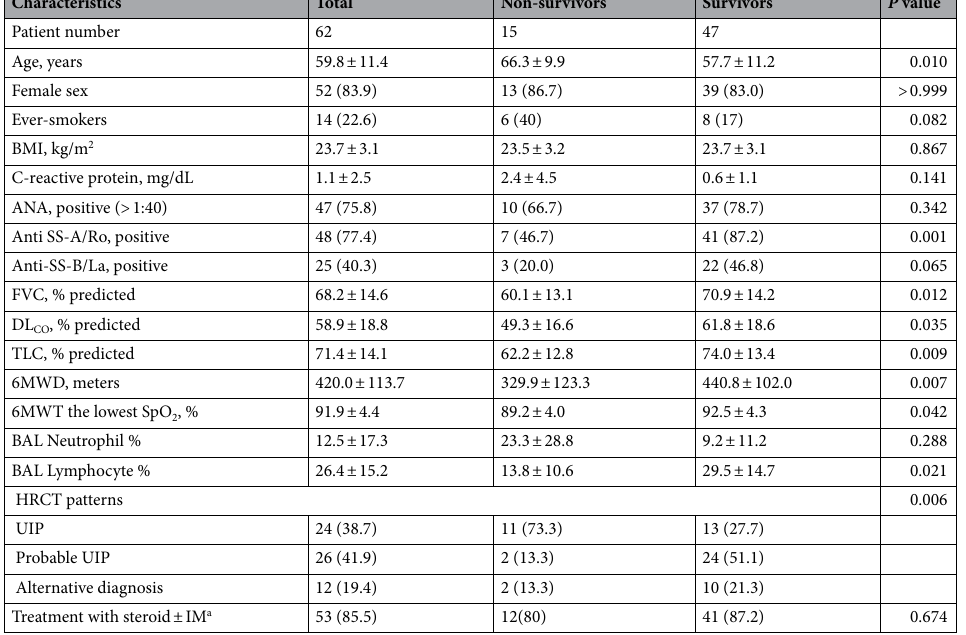
Table 1. Comparison of baseline characteristics between non-survivors and survivors among patients with SJS-ILD. Data are presented as mean ± standard deviation or number (%), unless otherwise indicated. 6MWD six-minute walk test distance, 6MWT the lowest SpO 2 lowest oxygen saturation during the six-minute walk test, ANA anti-nuclear antibody, BAL bronchoalveolar lavage, BMI body mass index, DL CO diffusing capacity of the lung for carbon monoxide, FVC forced vital capacity, ILD interstitial lung disease, IM immunosuppressants, SJS Sjögren syndrome, TLC total lung capacity. a The immunosuppressants included azathioprine (n = 22), cyclosporine (n = 21), mycophenolate mofetil (n = 27), and cyclophosphamide (n = 8).